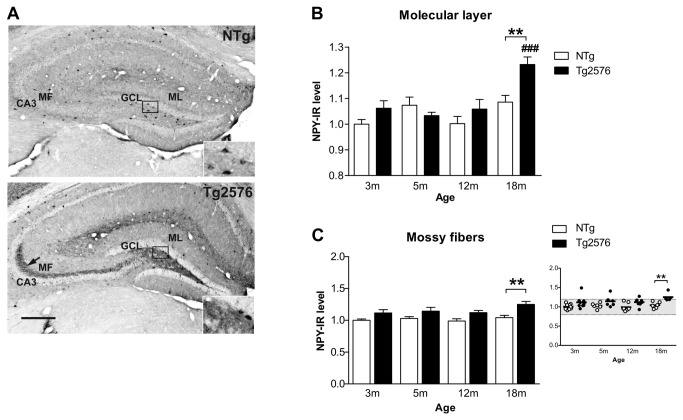
Ectopic expression of inhibitory neuropeptide Y in the dentate gyrus of Tg2576 mice with aging.(A) Neuropeptide Y (NPY) immunoreactivity in the dentate gyrus of 18 months-old NTg and Tg2576 mice. Albeit NPY staining was observed in the soma of some hilar cells in both NTg and Tg2576 mice (enlargements), a massive ectopic NPY expression in the mossy fibers running from the hilus to CA3 (arrow) was evidenced in Tg2576 mice only. (B) NPY immunoreactivity (NPY-IR) was quantified in the molecular layer of NTg and Tg2576 mice as a function of age (in months) (n=5-10 mice/group). NPY expression remained stable through aging in NTg mice while it increased significantly in Tg2576 mice at 18 months compared to 3, 5 and 12 month-old Tg2576 mice and compared to age-matched NTg control mice. (C) Quantification of NPY expression in the mossy fibers of Tg2576 and NTg mice along aging. An ectopic expression of NPY was observed in the mossy fibers of several Tg2576 mice, in proportions that increased with age, becoming statistically significant at 18 months, as shown in the scattered plot where each dot represents a mouse. Quantitative data represent mean ± SEM in B and C. Data were analyzed by two-way ANOVA with Bonferroni post-hoc: ###p<0.001 age effect for each genotype; **p<0.01 Tg2576 mice vs age-matched NTg, two-way ANOVA. ML: molecular layer, GCL: granular layer, MF: mossy fibers, CA3: Ammon’s horn 3. Scale bar: A=300µm.